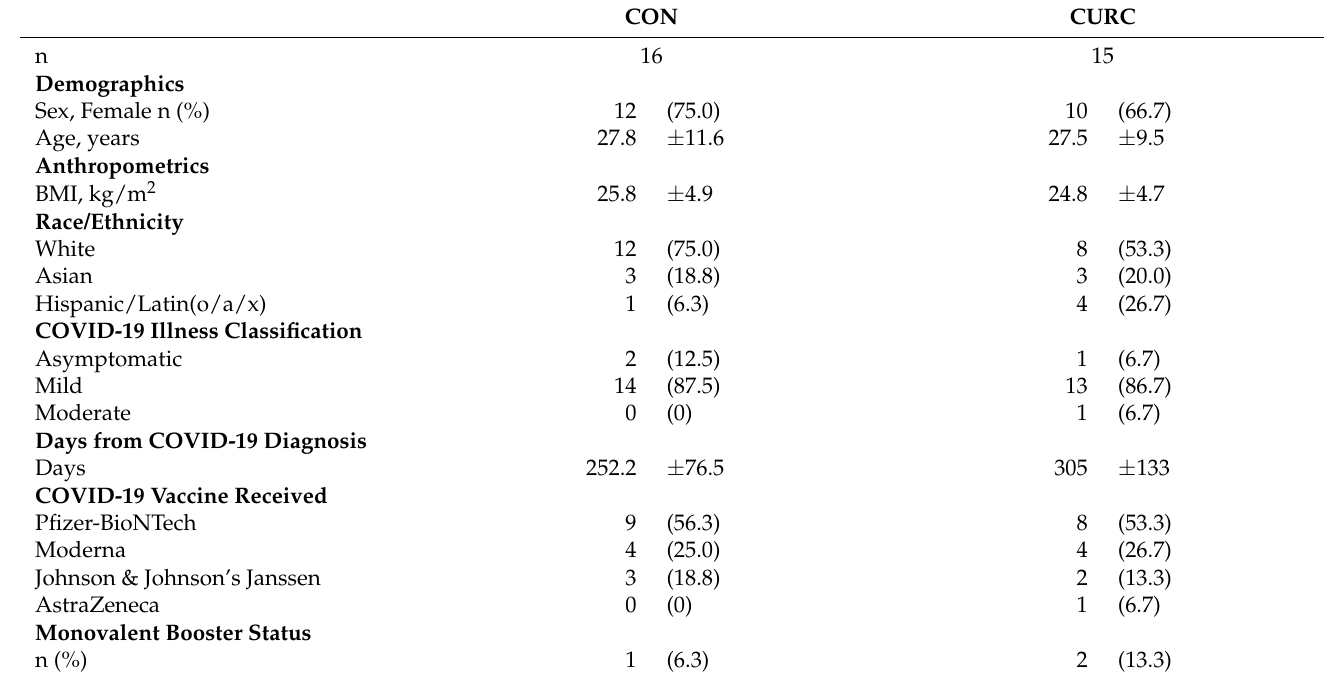
Table 1. Baseline characteristics of study participants ( n = 31) in the CURC and CON groups.